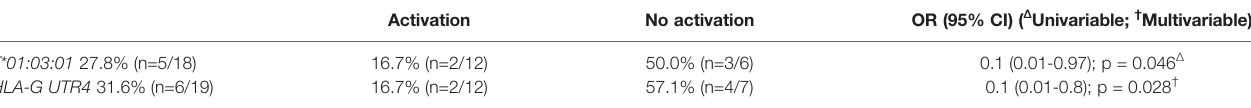
TABLE 3 | HLA I antibody complement activation according to HLA Ib polymorphisms. Activation No activation OR (95% CI) ( Δ Univariable; † Multivariable)